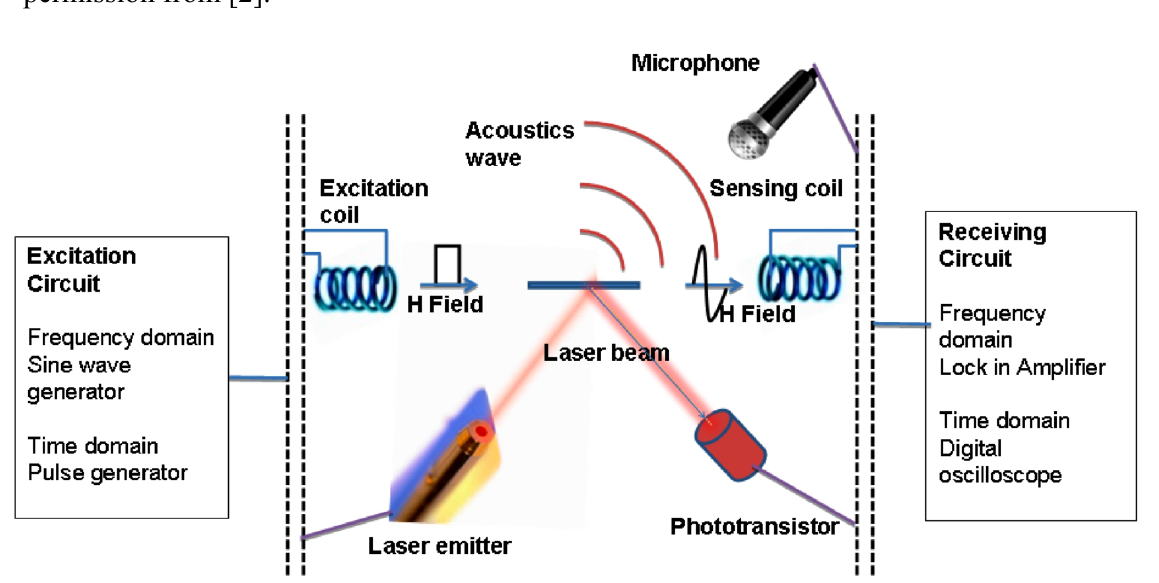
Figure 1. A magnetoelastic sensor strip is excited with a magnetic field. The sensor response can be detected by magnetic, acoustic or optical techniques. Reprinted with permission from